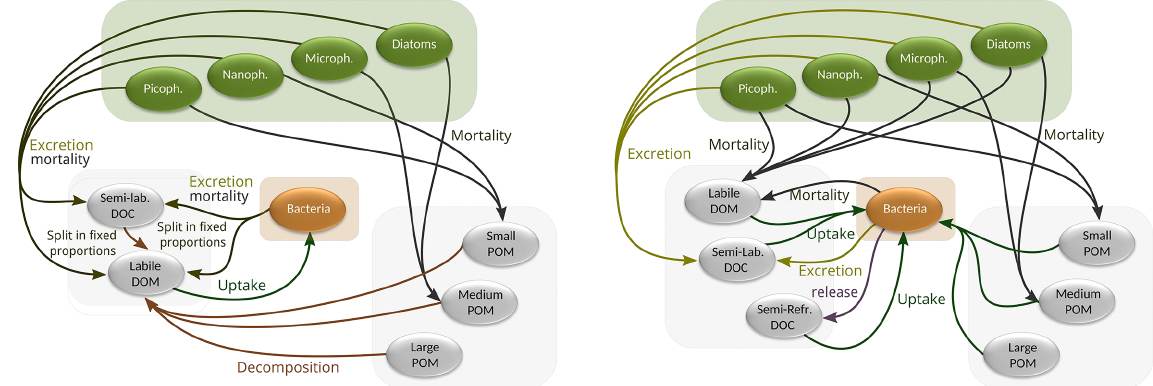
Figure 4. The microbial cycling of organic material for the standard bacteria model (left panel) and the dynamic decomposition model (right